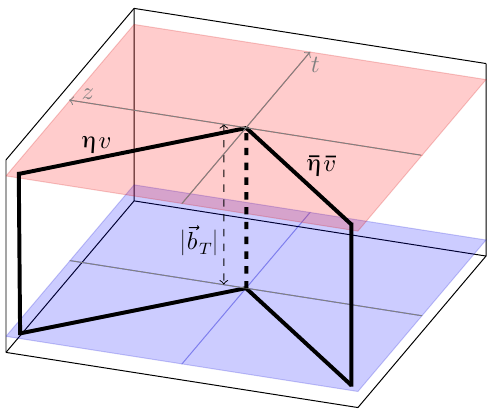
Figure 3 . Wilson line structure of the soft function, eq. (2.8) for η, ¯ η < 0 . Figure adapted from ref.